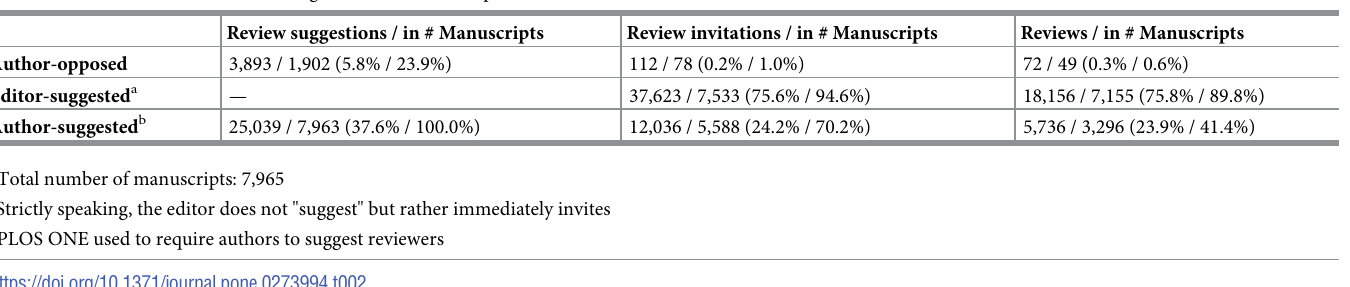
Table 3. Statistics per manuscript: Number of reviewers suggested by the author, invited, and who provided reviews across revisions. IQR = Interquartile